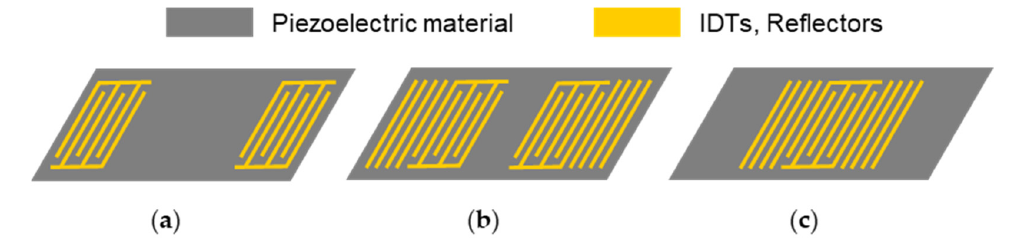
Figure 2. Schematics of surface acoustic wave devices: ( a ) delay line configuration; ( b ) two-port resonator; ( c ) one-port resonator. resonator; ( c ) one-port